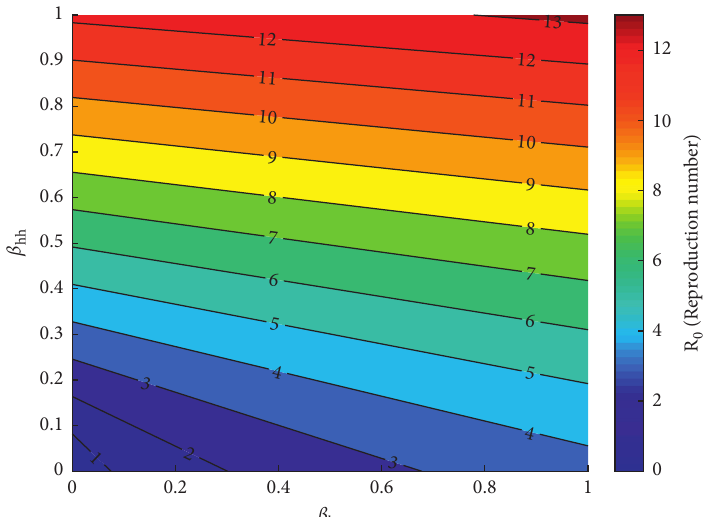
Figure 10: The contour plot of the basic reproduction number as a function of the human-to-vector transmission rate ( β to-human transmission rate ( β hh ) .